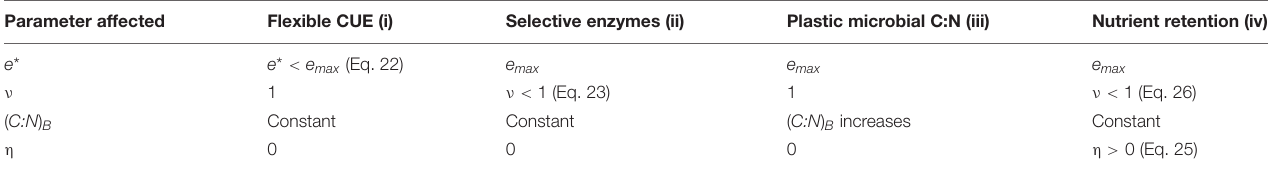
TABLE 2 | Summary of model implementation of the four resource use modes, and changes of model parameters when microorganisms are N limited (see also Figure 1B ). Parameter affected Flexible CUE